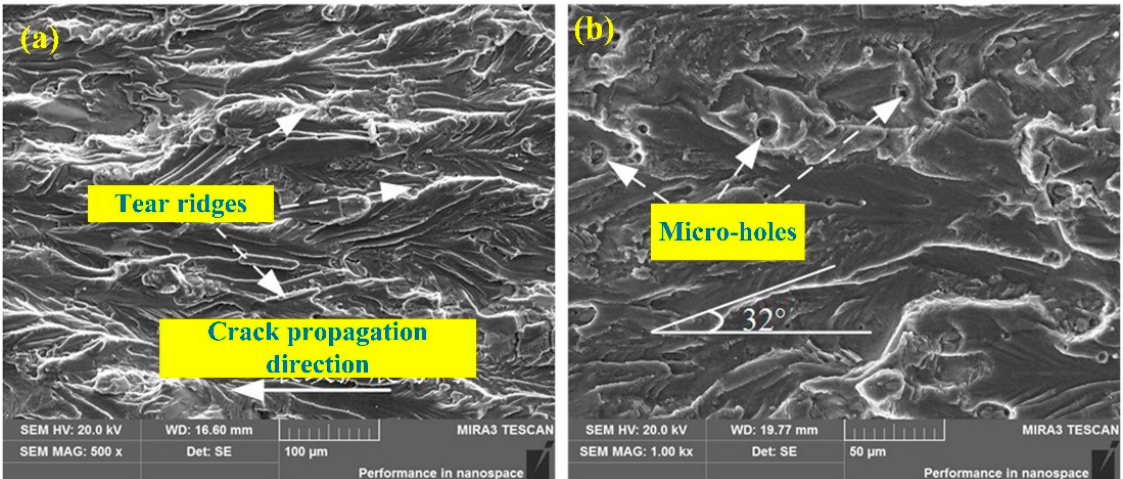
Figure 7. Morphology of fracture of 2524-T3 aluminum alloy in the initial stage of fatigue crack propagation: ( a ) tear ridges and crack propagation direction; ( b ) micro-holes and angle difference in the main crack propagation direction.